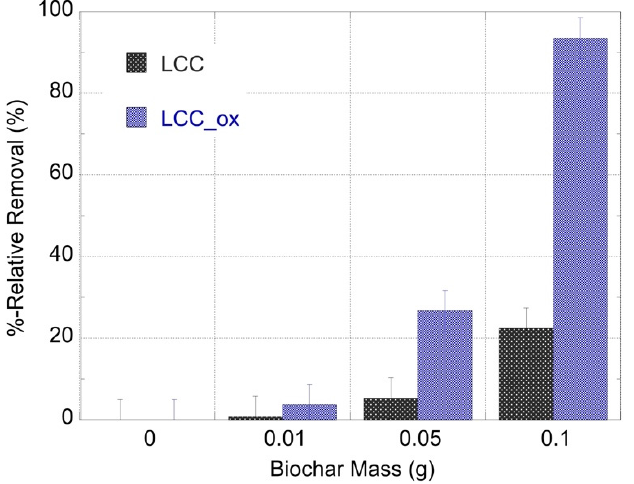
Figure 4. The %-relative removal efficiency of U-232-traced aqueous solutions after treatment with Figure 4. The % ‐ relative removal efficiency of U ‐ 232 ‐ traced aqueous solutions after treatment with different masses of unmodified (LCC) and oxidized biochar (LCC_ox). [U-232] = 8.6 × 10 − 14 mol/L, different masses of unmodified (LCC) and oxidized biochar (LCC_ox). [U ‐ 232] = 8.6 × 10 − 14 mol/L, pH 4 and ambient conditions. pH 4 and ambient